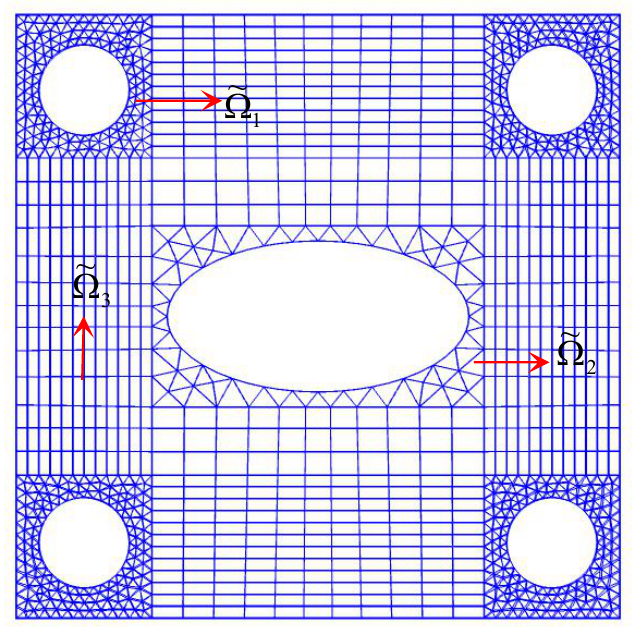
Figure 1. Hybrid finite element mesh discretization and subregion combination diagram. There are three different types of meshes in the square plate Ω with holes, and the region division is completed by nesting and combining them with each other.